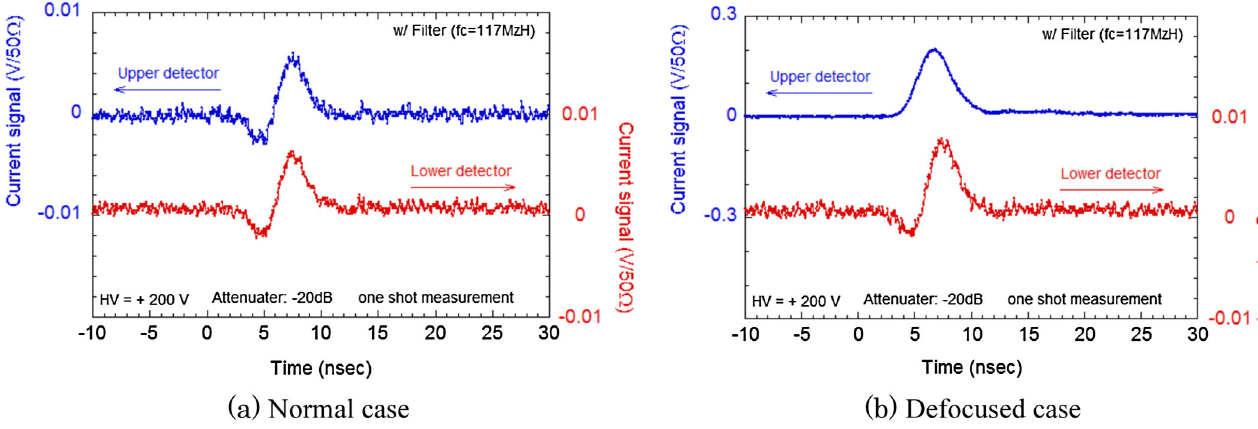
FIG. 14. Signals from the beam halo